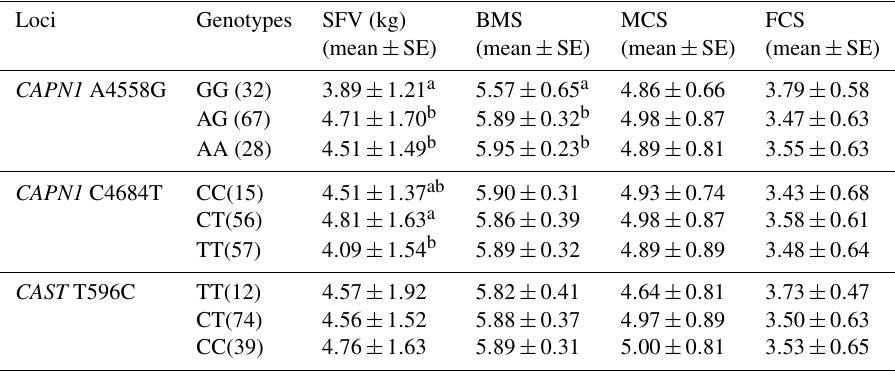
Table 3. Association analysis between SNP effects and meat quality traits in Chinese Simmental